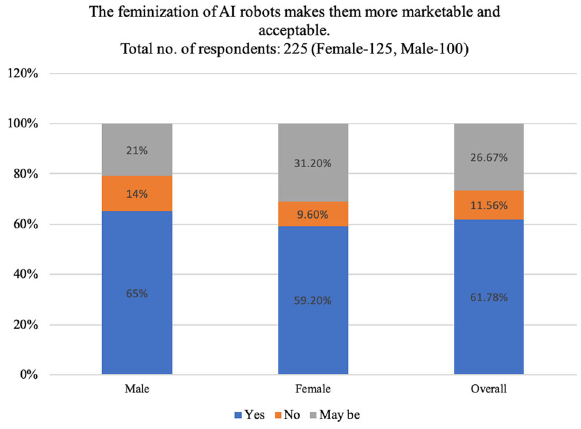
Fig. 14 The feminization of AI robots makes them more marketable and acceptable. Total no. of respondents: 225 (Female: 125, Male: 100).